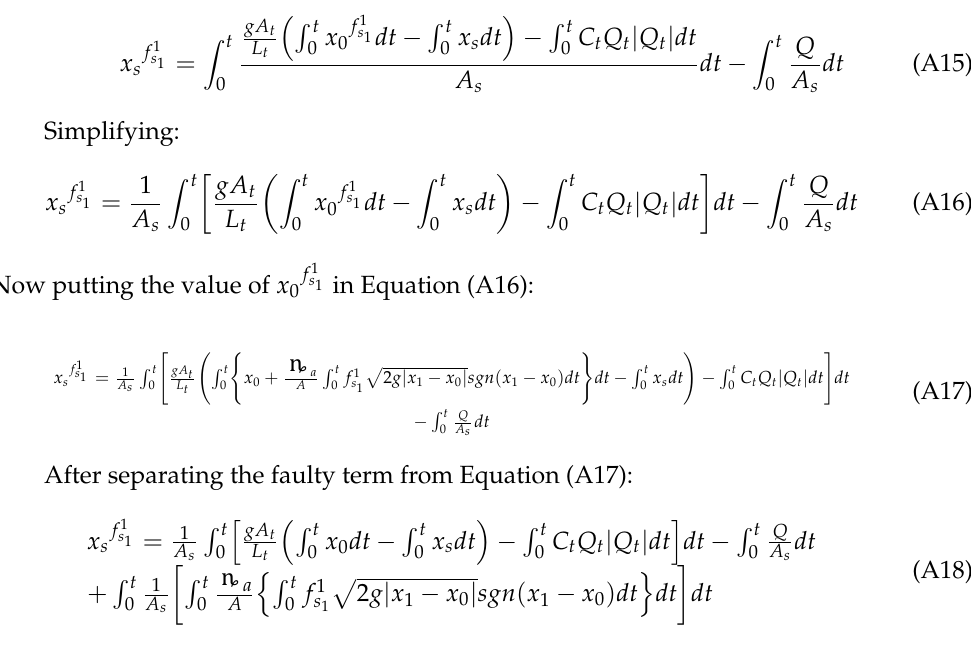
Figure 1. Three-pond hydraulic system.